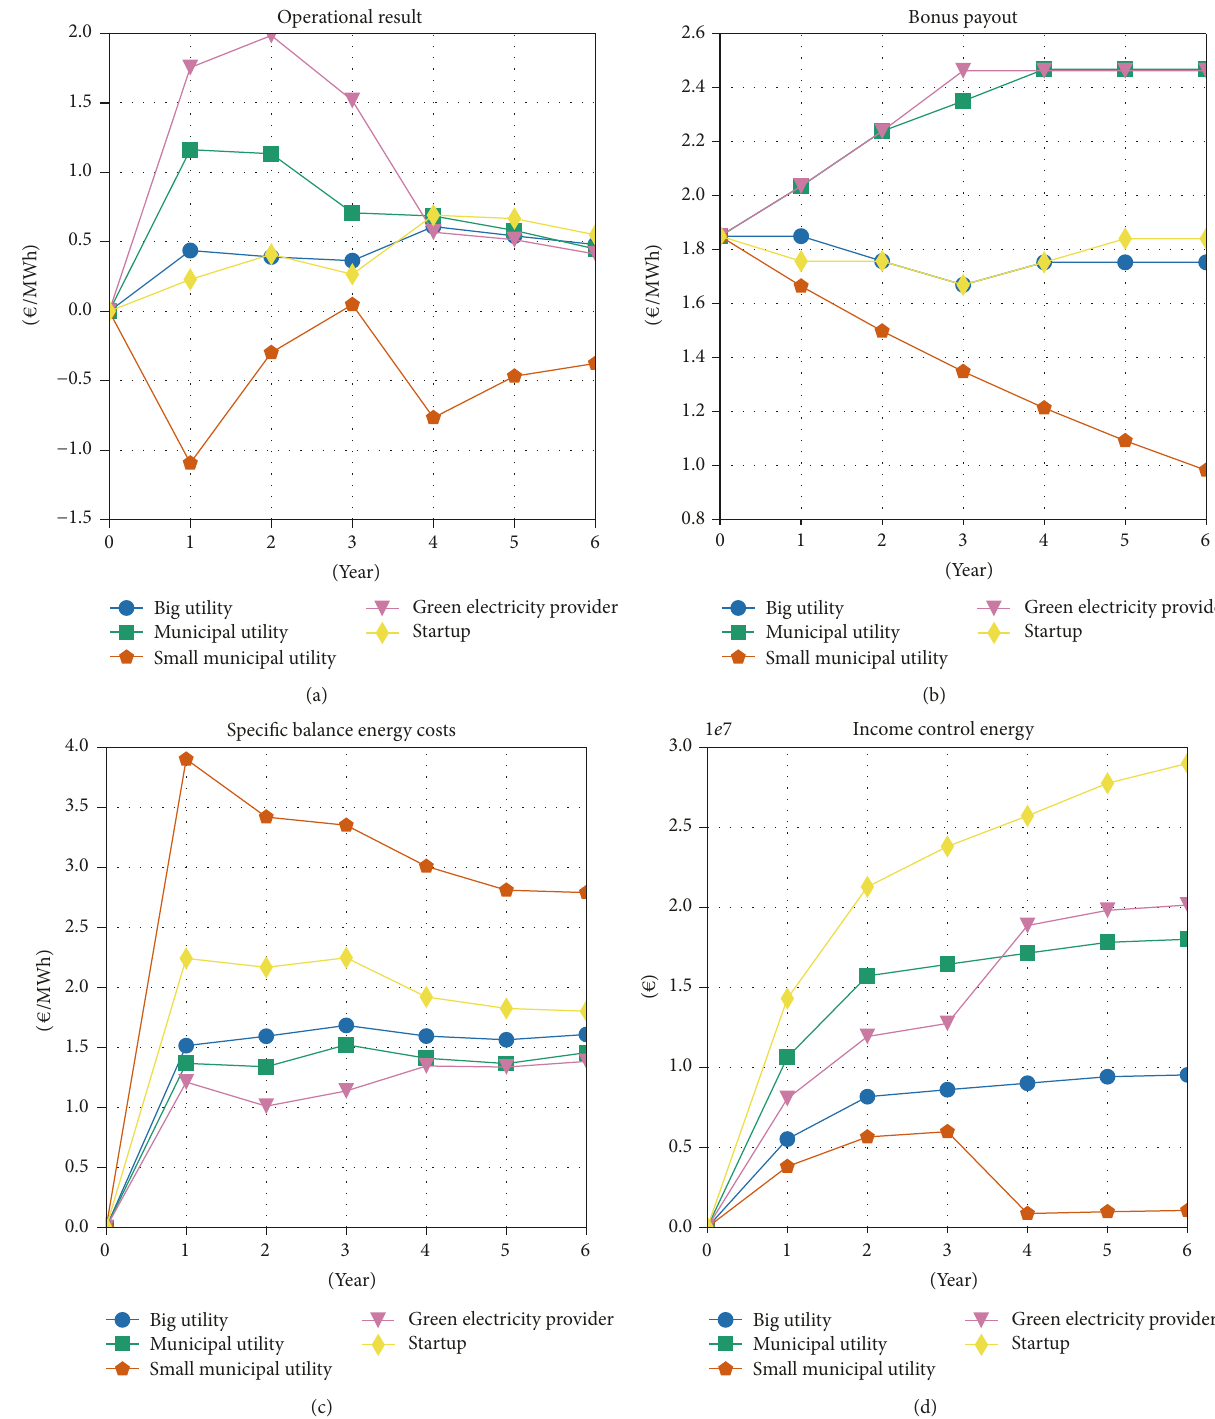
Figure 5: Specific operational results, bonus payouts, balance energy costs, and income from the control energy market for all 5 marketers in the first